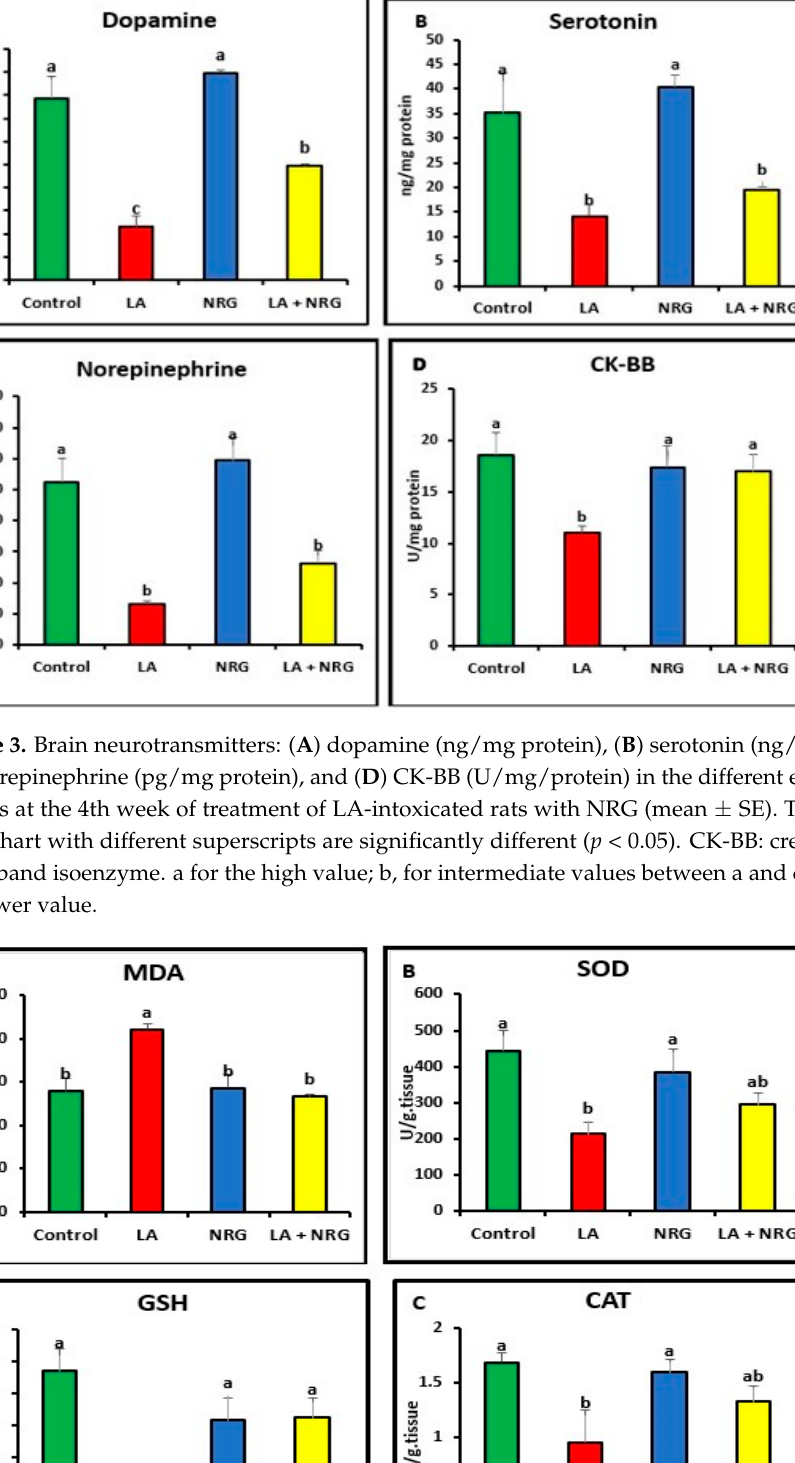
Figure 5. Brain oxidative/antioxidative parameters: ( A ) MDA (nmol/g tissue), ( B ) SOD (U/g tissue), ( C ) catalase (U/g tissue), and ( D ) GSH (mg/g tissue) at the 4 th week of treatment of LA-intoxicated rats with NRG (mean ± SE). The means in each chart with di ff erent superscripts are signi fi cantly